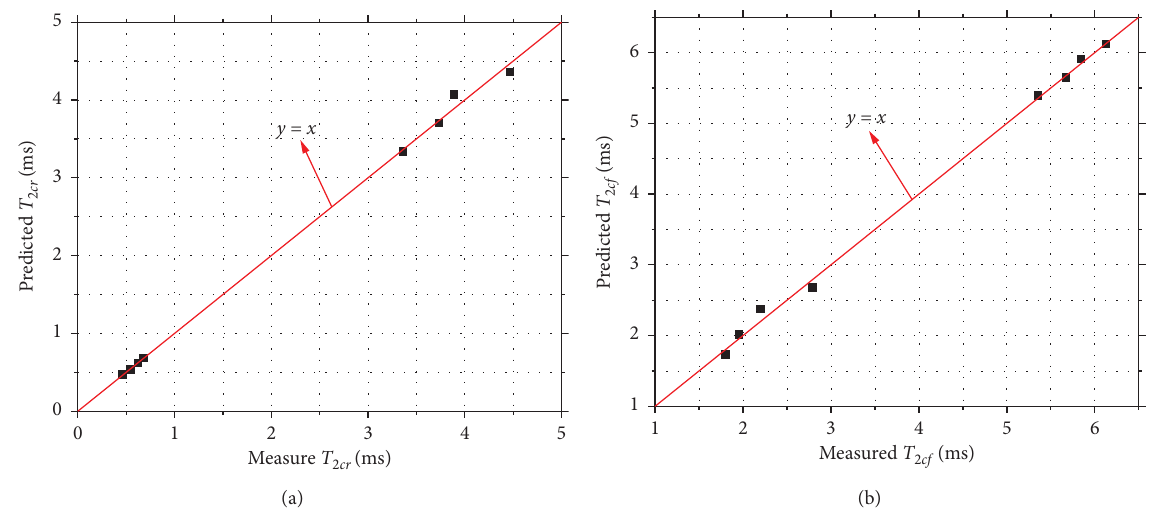
Figure 12: Comparison of the predicted and measured double T